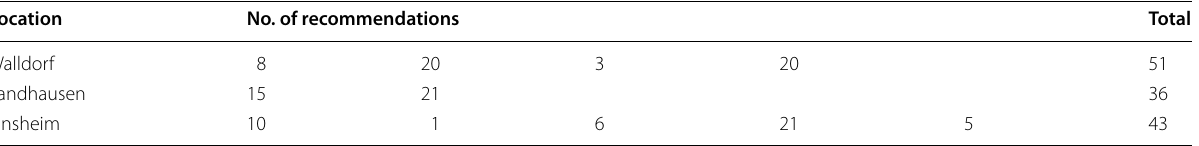
Source ZEW inclusive soccer project